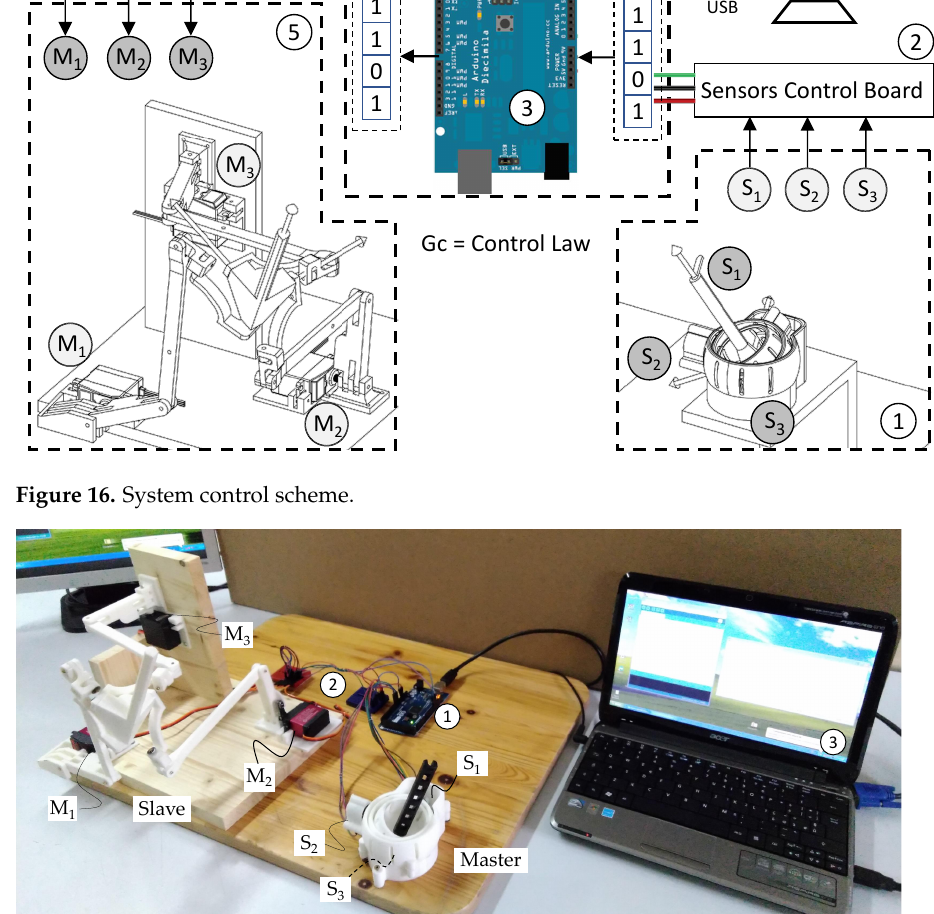
Figure 17. An overview of the proposed test bed of the mechatronic system.